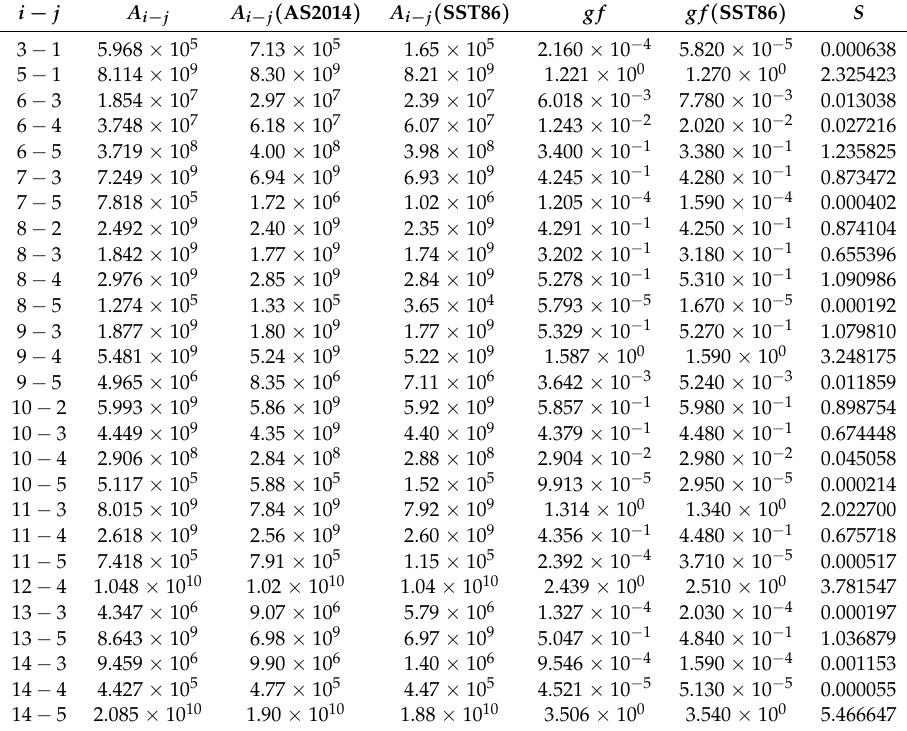
Table 2. Present radiative decay rates A ij (in s − 1 ) and weighted oscillator strengths gf compared to those from Christensen et al. [26] (SST86) and to those from [25] (AS2014) for some Ar VII allowed transitions. Line strengths S are also presented. i and j label the levels as in Table